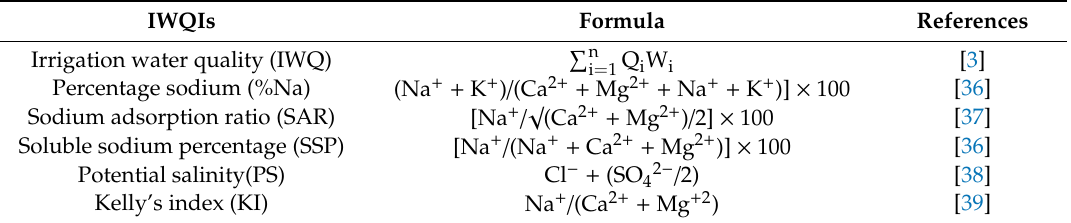
Table 1. Full name, abbreviation, formula, and references for di ff erent irrigation water quality indicators (IWQIs) applied in this study. IWQIs